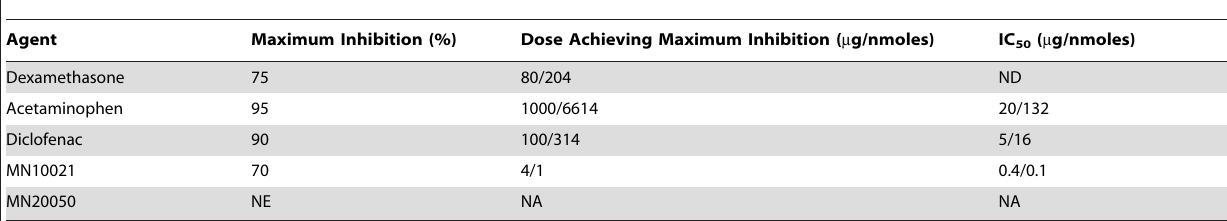
Table 2. Potency of MN10021 in Mouse Peritonitis Model of Inflammation.